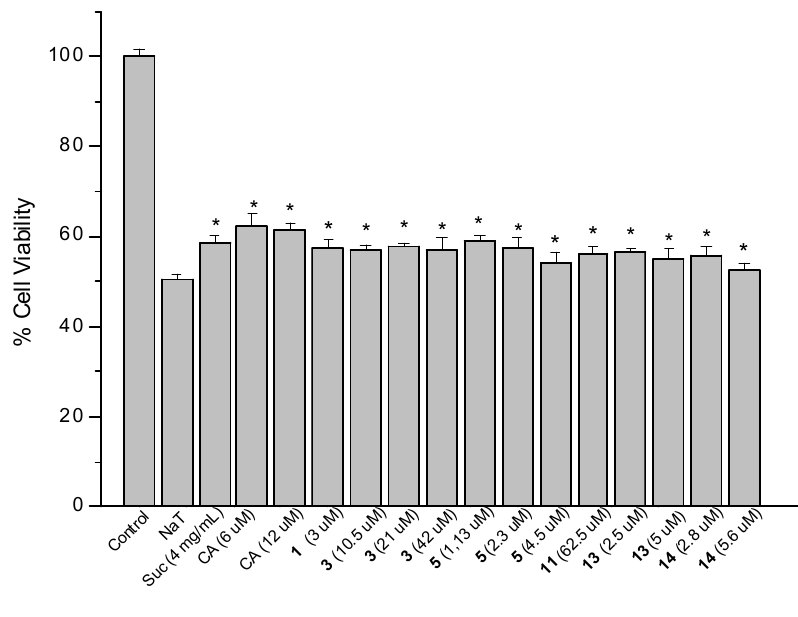
Figure 2. Effect of pre-treatment during 60 min with the reference compound sucralfate ( Suc ), carnosic acid ( CA ) and derivatives 1 , 3 , 5 , 11 , 13 and 14 followed by an incubation during 30 min with 10 mM NaT on the viability of AGS cells determined by the neutral red uptake assay. Each value represents the mean ± SD of three different experiments in quadruplicate. ANOVA followed by Dunnett’s multiple comparison test. * p < 0.05 compared to NaT